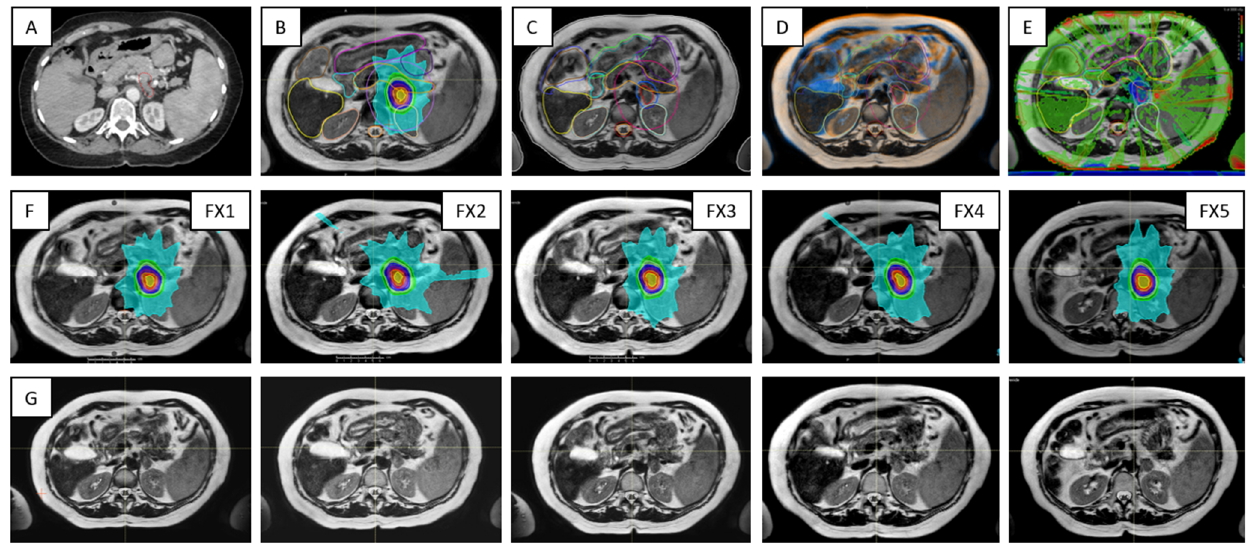
Figure 8. Pancreas online adaptive sessions, all including five fractions. The time spent on key processes in the adapt-to-shape workflow.